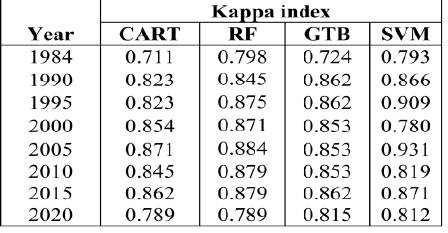
Table 2 . Average Kappa coefficients for the classifiers per year. Table 1 . All-years average LULC class classification accuracy metrics.